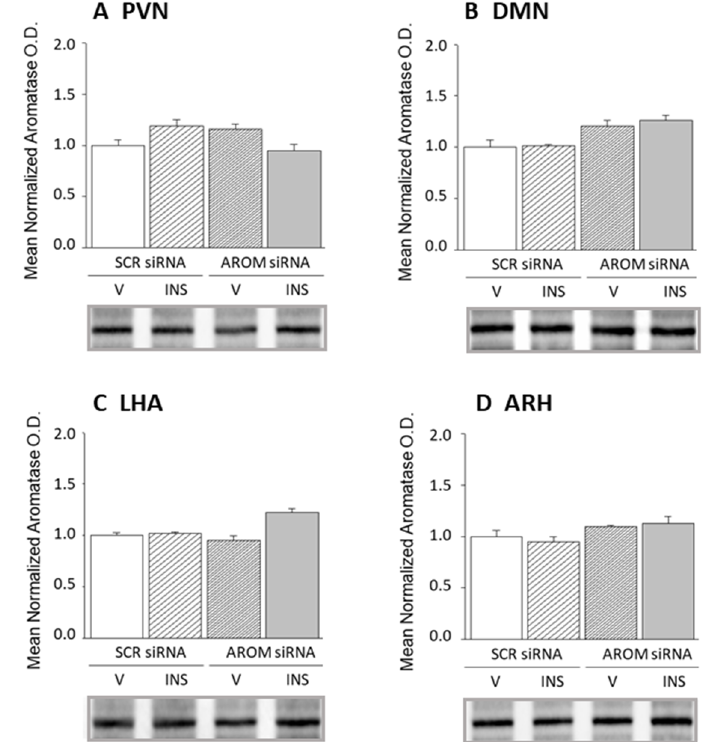
Figure 5. Effects of aromatase siRNA delivery to the VMN on aromatase protein expression in the paraventricular (PVN), dorsomedial (DMN), and arcuate (ARH) hypothalamic nucleus and lateral hypothalamic area (LHA). Data show mean normalized PVN ( A ), DMN ( B ), LHA ( C ), or ARH ( D )